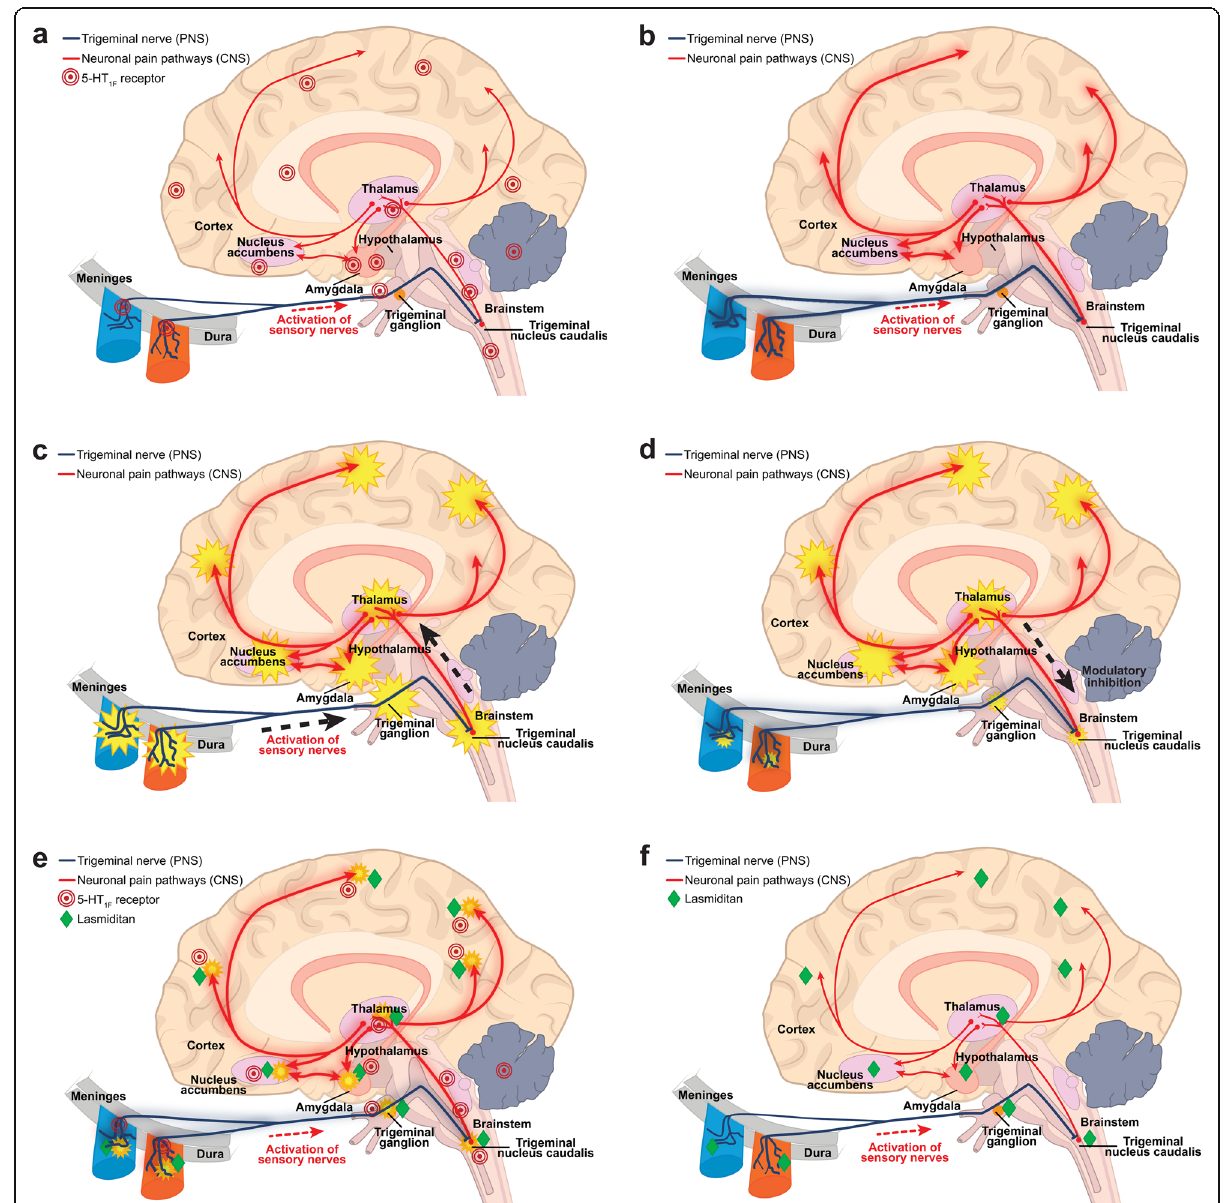
Fig. 1 a Trigeminal and pain pathways associated with pain signaling during a migraine attack plus 5-HT1F receptor locations in PNS and CNS areas involved in the pathophysiology of migraine. b Activation of trigeminal and pain pathways during a migraine attack; sustained or repeated activation of pain pathways leads to increasing sensitivity of trigeminal neurons in the brain stem. c Activated nerves release various substances including neuropeptides and neurotransmitters such as CGRP and glutamate that can exacerbate neurogenic inflammation and nociceptor pain signaling in migraine; this may hyperexcite neurons to propagate pain responses and enhance central sensitization. d In addition to other endogenous inhibitory processes, serotonin from pain modulating pathways activates 5-HT receptors that can inhibit neuropeptide and neurotransmitter release, thereby inhibiting their local activity and downstream neuronal signaling; however, these modulatory mechanisms may be disturbed in migraine pathophysiology, predisposing patients with migraine to an attack. e Lasmiditan crosses the blood-brain barrier and presumably acts in both the PNS and the CNS to selectively activate 5-HT1F receptors to inhibit the release of neuropeptides and neurotransmitters such as CGRP and glutamate, thereby inhibiting their local activity and migraine attack pain pathways. f Preclinical and ex vivo human evidence suggests that lasmiditan inhibits PNS trigeminal nerve and CNS pain signaling pathways, exerting therapeutic effects in the treatment of migraine without causing vasoconstriction. Abbreviations: CNS, central nervous system; mRNA, messenger ribonucleic acid; PNS, peripheral nervous system. Note: 5-HT1F receptor locations are based on human and animal mRNA, immunohistochemistry, and functional biology